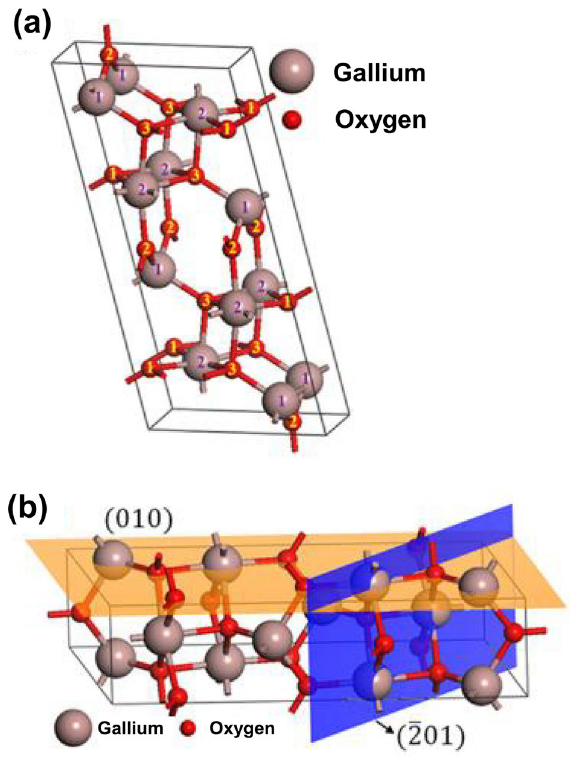
Fig. 1 a β -Ga surfaces